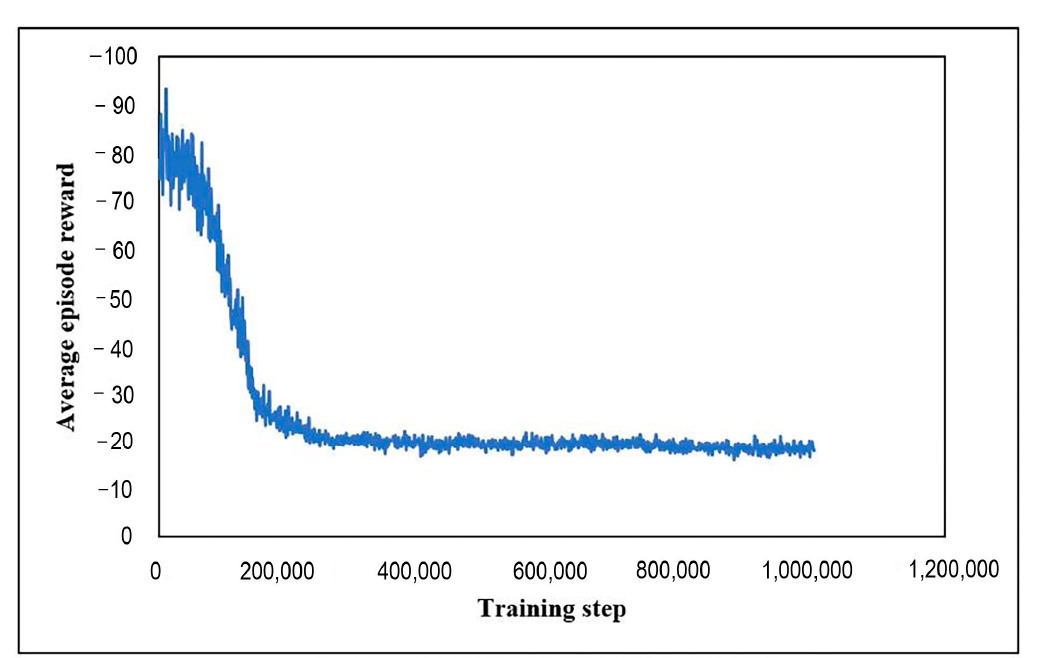
Figure 7 plots the training curve.